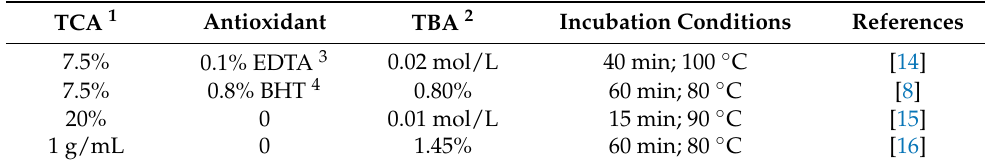
Table 1. Methods parameters for TBARS